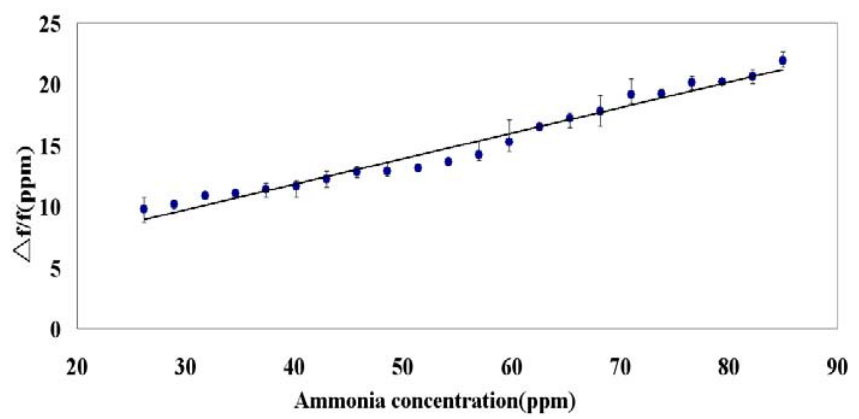
Figure 10. Responses of the SAW gas sensor to the concentration of